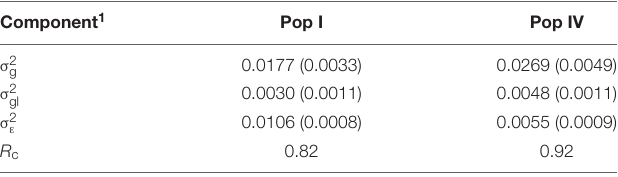
rates in seeds harvested in 2013 and 2014 also differed significantly (Wilcoxon signed rank test: P = 0.013 Population I, and P < 0.01 Population IV) ( Figure 5 ). Transmission rates were higher in 2014, which was generally warmer than 2013, with higher rainfall during the spring and a drier summer ( Supplementary Figure S1